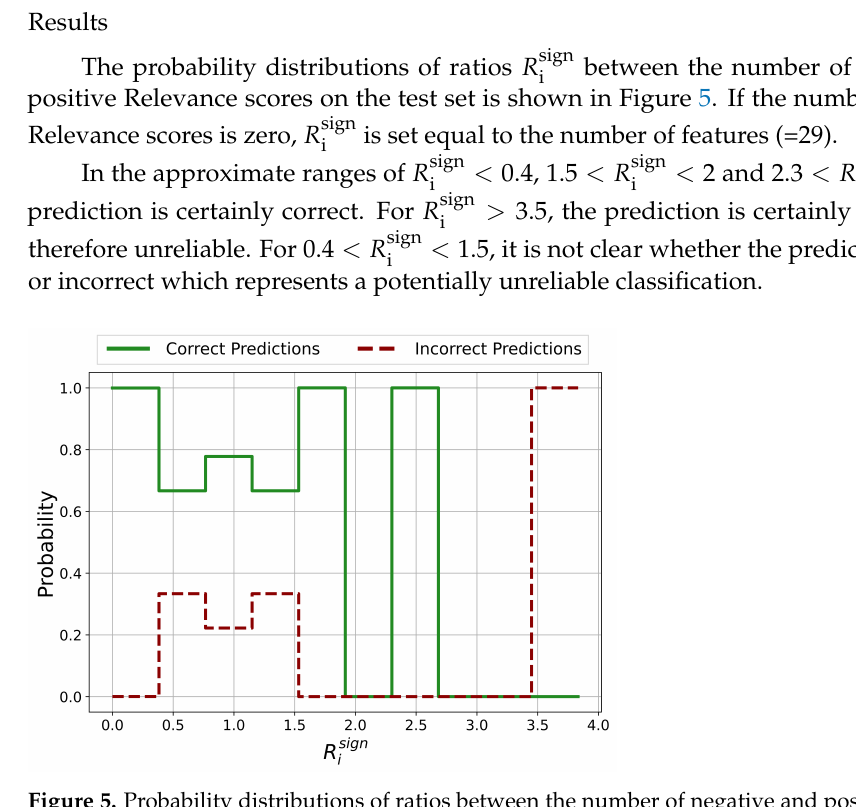
Figure 5. Probability distributions of ratios between the number of negative and positive Relevance scores for correct (green solid line) and incorrect (red dashed line) predictions. Potentially unreliable < 1.5. If R sign > 3.5, the predictions are not reliable as it is predictions occur in the range 0.4 < R sign i i certainly incorrect.